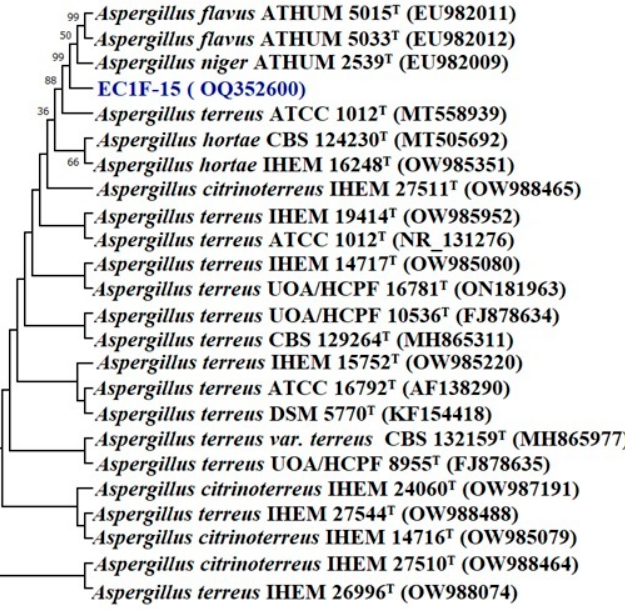
Figure 1. Phylogenetic tree of isolate Aspergillus sp. EC1F-15 obtained by maximum likelihood method based on the Kimura two-parameter model.